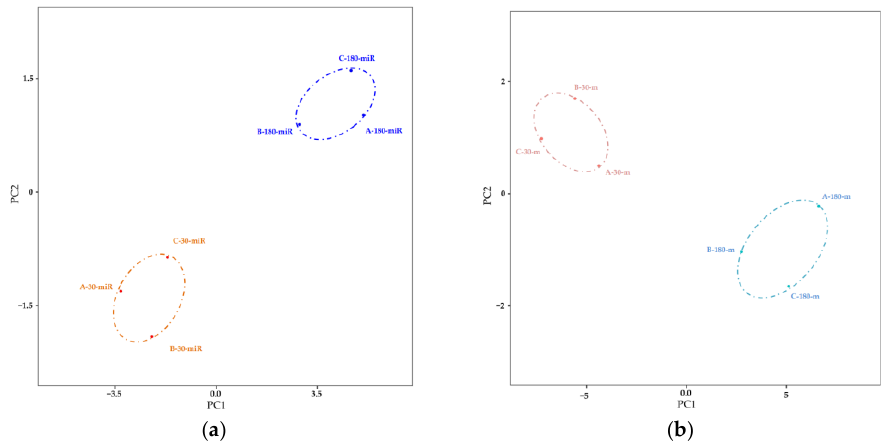
Figure 1. Principal component analysis of transcriptome sequencing data. ( a ) Principal component analysis of miRNA sequencing data. ( b ) Principal component analysis of mRNA sequencing data.